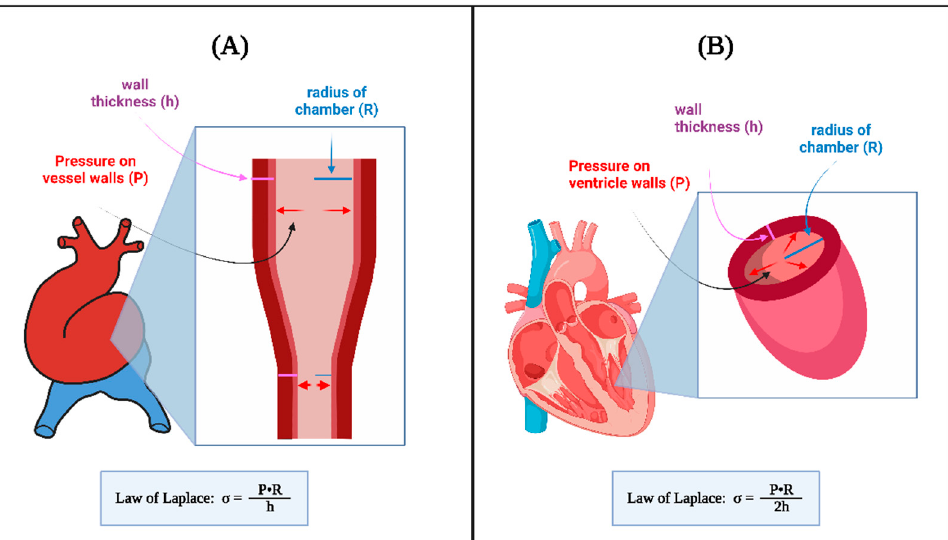
Figure 5. The law of Laplace relates transmural pressure P to circumferential wall stress σ . In a developing tubular heart ( A ) and a spherical model of a ventricle ( B ) there is a proportional relationship between circumferential stress, σ , and the fluid pressure acting on the walls, as well as the radius R. There is also an inversely proportional relationship between circumferential wall stress and wall thickness, h. While approximate, Laplace law can be used to estimate wall stress values, and the effects of P and heart dimensions on wall stress. Created with BioRender.com (accessed on 24 July 2022).